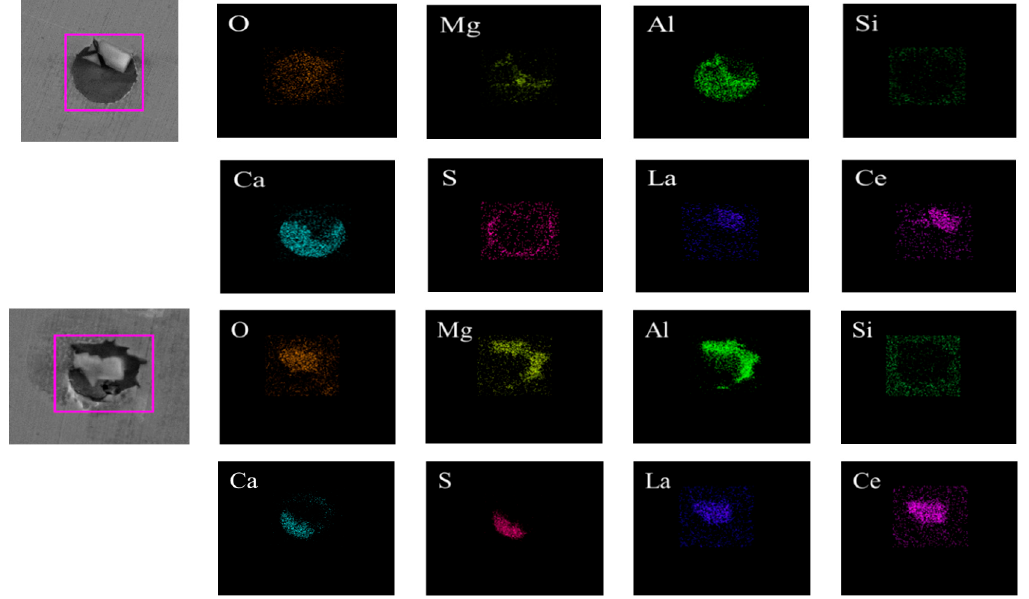
Figure 7. Surface scanning results for (La, Ce)Al 2 O 3 +CaO-Al 2 O 3 -MgO in the tundish impact zone.